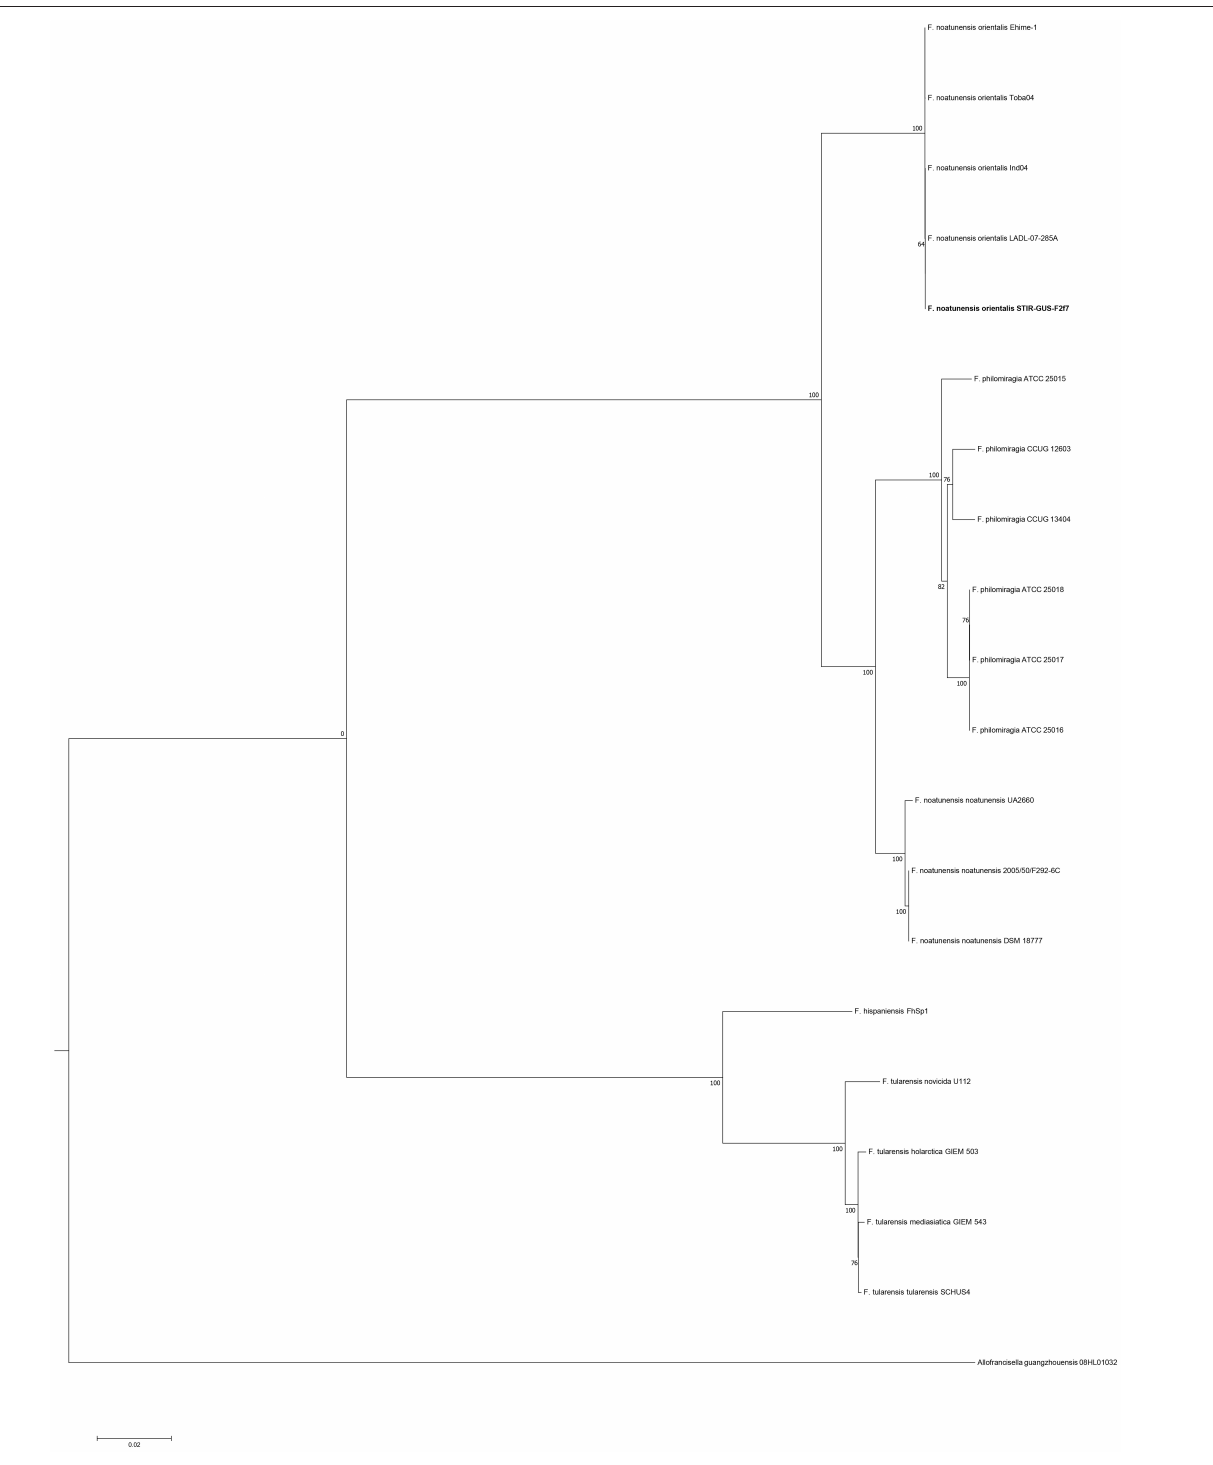
FIGURE 5 | Molecular phylogenetic analysis of the family Francisellaceae based on the concatenated sequence of the house keeping genes (15,750 nt). The evolutionary history was inferred using the Maximum Likelihood method based on the General Time Reversible model (GTR + G + I). The tree with the highest log likelihood ( − 52,931.87) is shown. The percentage of trees in which the associated taxa clustered together is shown next to the branches. Initial trees for the heuristic search were obtained by applying the Neighbor-Joining method to a matrix of pairwise distances estimated using the Maximum Composite Likelihood (MCL)